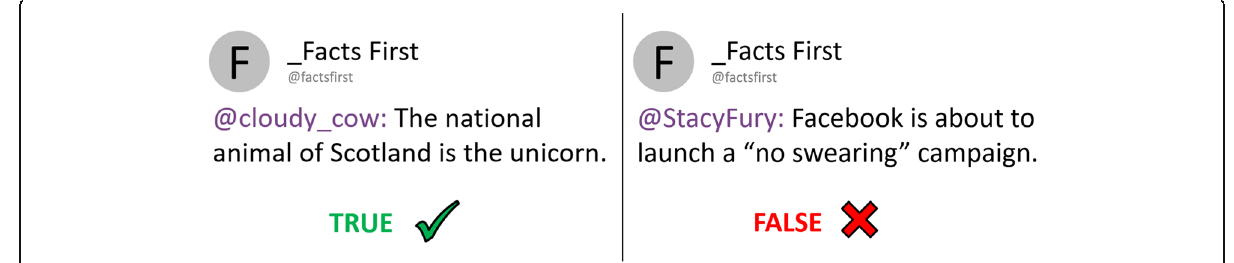
Fig. 2 Example of an affirmation (left) and correction (right)